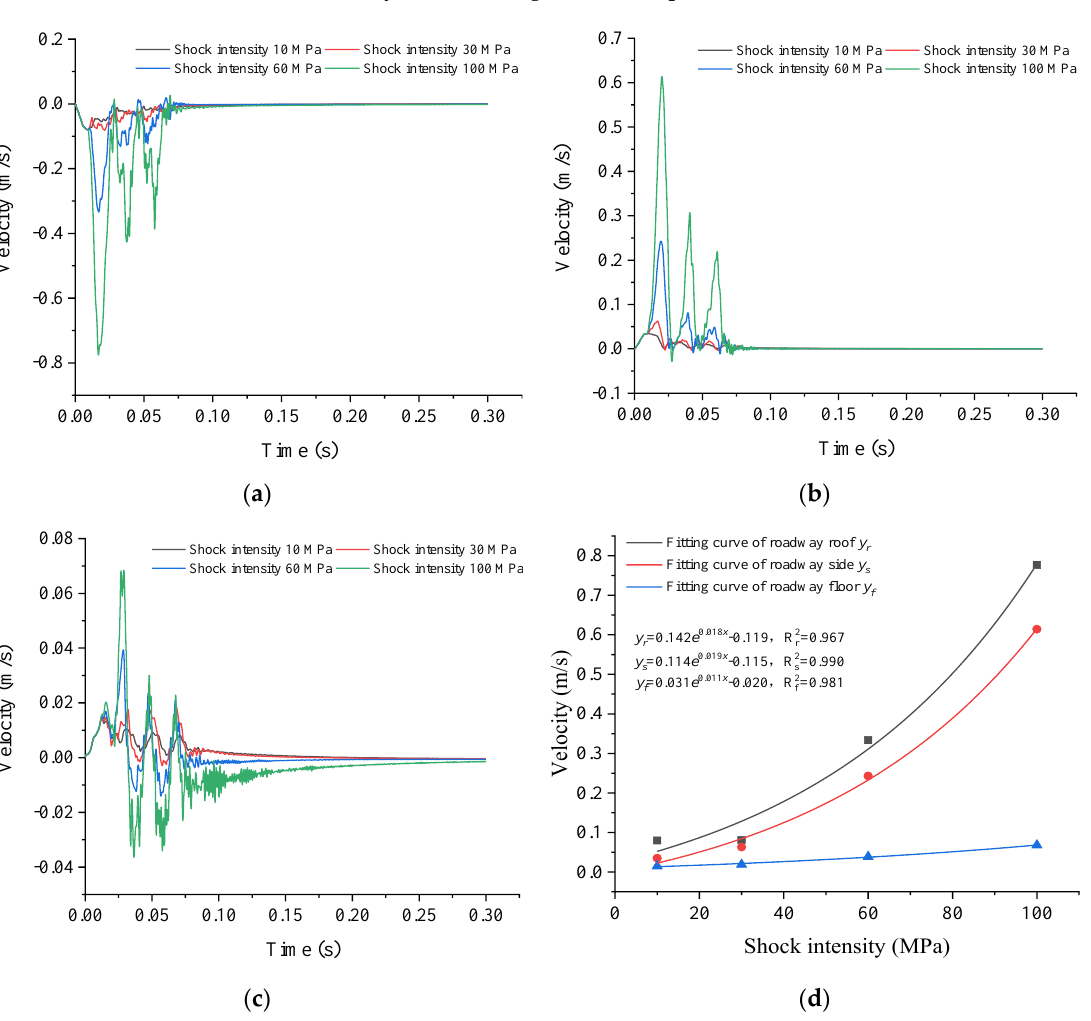
Figure 7. Velocity–time curve of the surrounding rock of the roadway for different shock intensities. ( a ) Roadway roof; ( b ) roadway side; ( c ) roadway floor; ( d ) maximum velocity fitting curve.